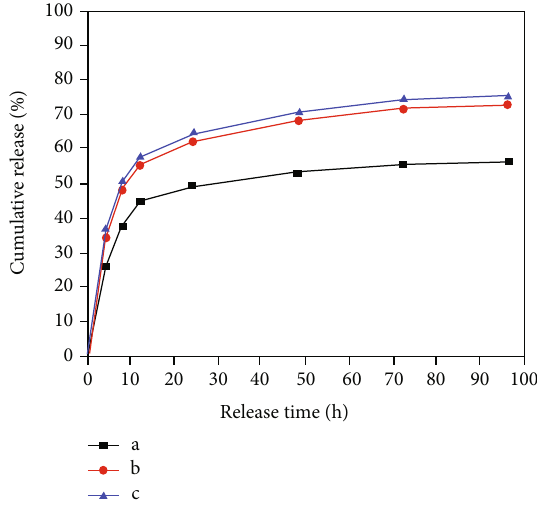
Figure 68: Release of fl ower garland fragrance from polyacrylate/ para ffi n microcapsules in surfactant solution (SDS, 20 wt %) under di ff erent storage temperatures: (a) 30 ° C; (b) 40 ° C; (c) 50 ° C